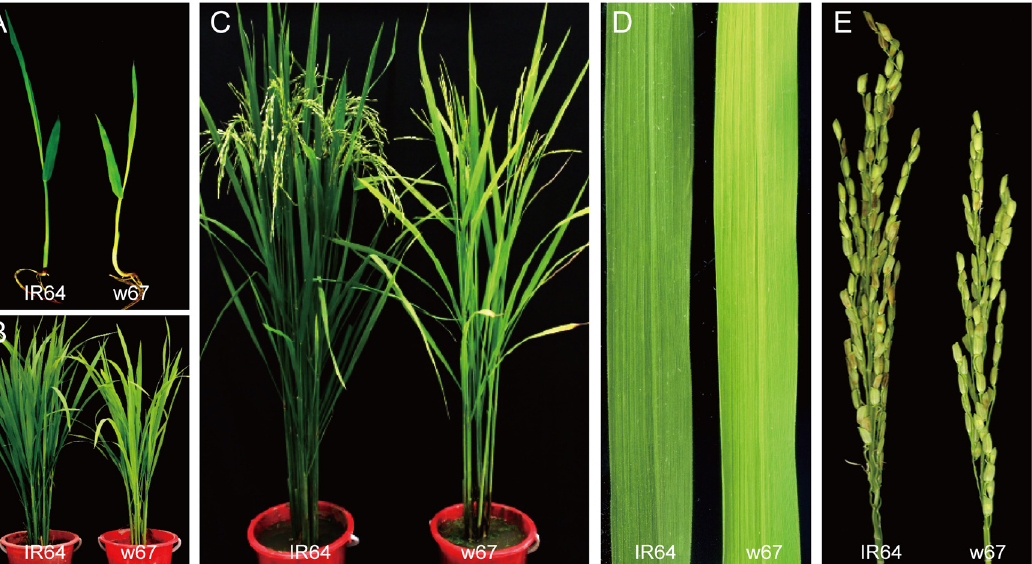
Fig 1. Phenotype of w67 mutant. A-C, phenotype of IR64 and w67, 5-day-old (A), 9-week-old (B) and 14-week-old (C); D, Leaf blade of 4-week-old IR64 and w67; E, panicles of IR64 and w67.